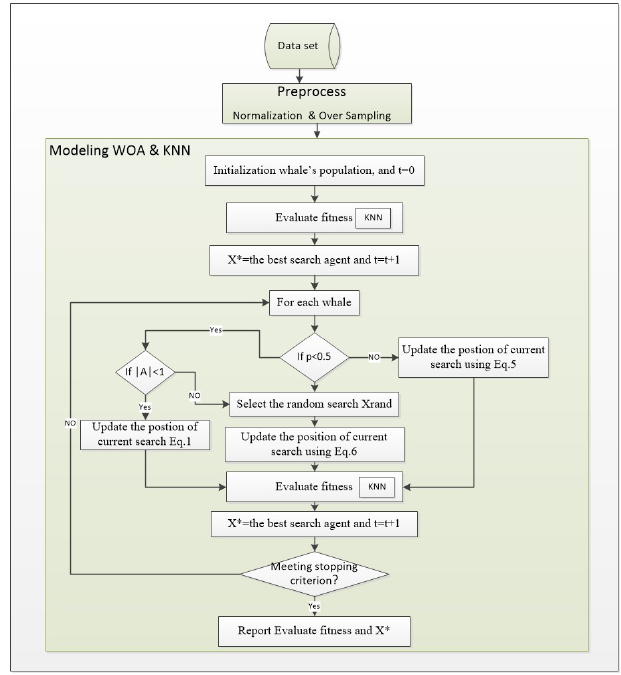
Algorithm 1 Hybrid WOA and KNN